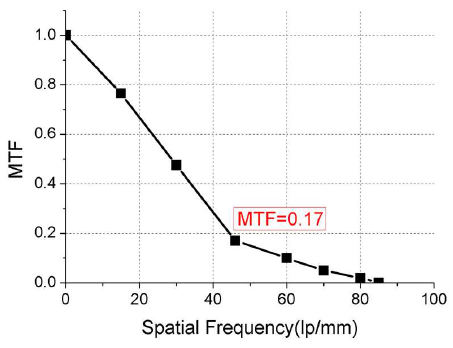
Figure 17. Dynamic modulation transfer function curves of Luojia1-01 satellite.